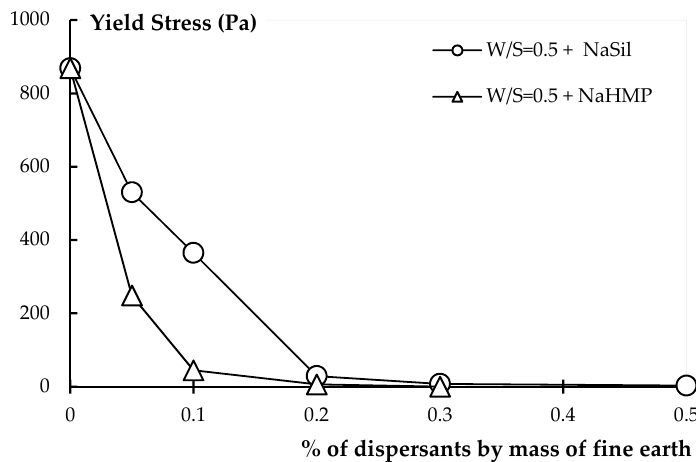
Figure 3. Effect of NaHMP and NaSil on the yield stress of earth paste.